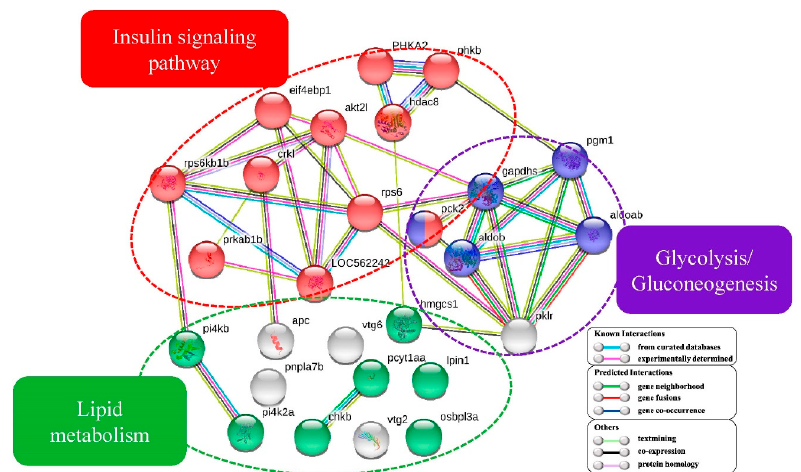
Figure 5. Protein-protein interaction networks of twenty-seven differentially expressed phosphoproteins (DEPP) associated with lipid metabolism and glucose metabolism. Akt2l, V-akt murine thymoma viral oncogene homolog 2, -like; Aldoab, fructose-bisphosphate aldolase; Aldob, fructose-bisphosphate aldolase B; Crkl, V-crk avian sarcoma virus CT10 oncogene homolog-like; Eif4ebp1, eukaryotic translation initiation factor 4E-binding protein 1; Gapdhs, glyceraldehyde-3- phosphate dehydrogenase; Hdac8, phosphorylase b kinase regulatory subunit; Pck2, phosphoenolpyruvate carboxykinase 2 (mitochondrial); pgm1, phosphoglucomutase-1; Pklr, pyruvate kinase; Phka2, phosphorylase b kinase regulatory subunit; Prkab1b, protein kinase, AMP- activated, beta 1 non-catalytic subunit, b; Rps6kb, ribosomal protein S6 kinase b 1b; Rps6, 40S ribosomal protein S6; Apc, adenomatous polyposis coli; Osbpl3a, oxysterol-binding protein; Pnpla7b, patatin-like phospholipase domain-containing 7b; Pi4kb, phosphatidylinositol 4-kinase beta; Pi4k2a, phosphatidylinositol 4-kinase type 2-alpha; Lpin1, lipin 1; Pcyt1aa, phosphate cytidylyltransferase 1, choline, alpha a; Hmgcs1, 3-hydroxy-3-methylglutaryl coenzyme A synthase; Vtg6, vitellogenin 6; Vtg2, vitellogenin 2; Chkb, choline kinase